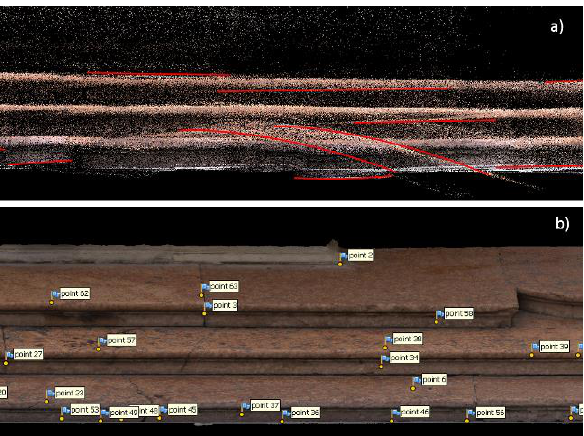
Figure 8. Manual intervention in the images alignment phase for a portion of the North side steps: a) sparse cloud obtained by automatic processing, the red lines highlight erroneous trends of points; b) the final mesh with the markers manually added to correct the images